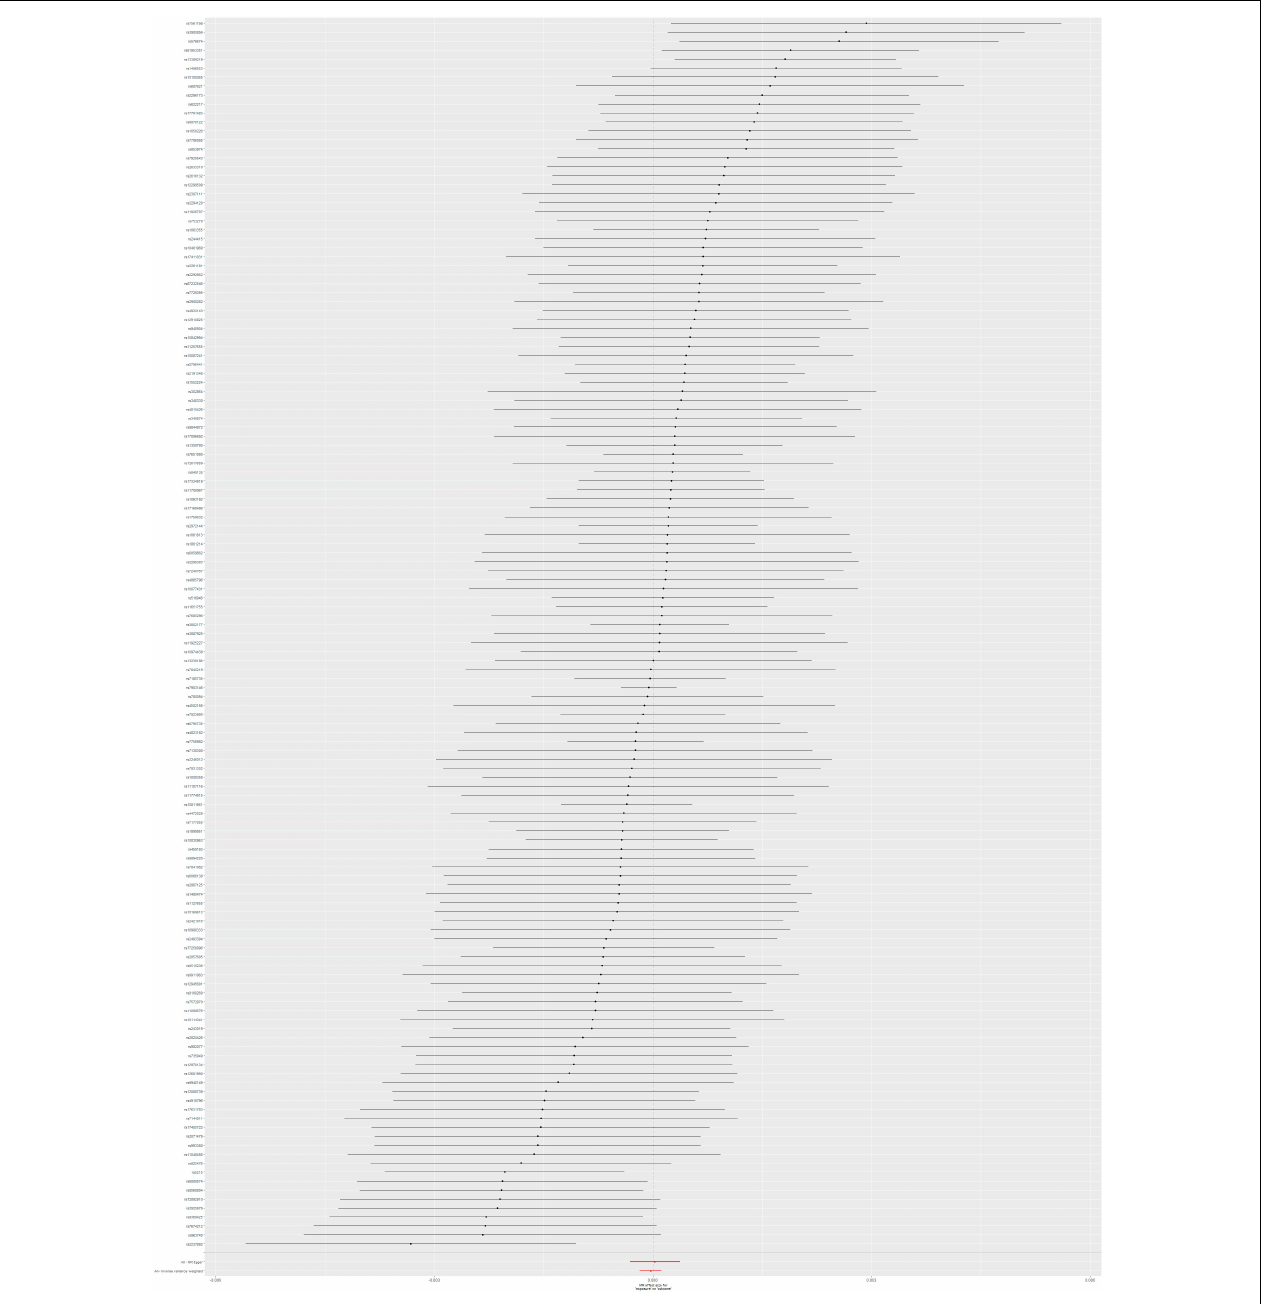
FIGURE 5 | Forest plot: the associations between T2DM-related SNPs and pneumonia risk. T2DM, type 2 diabetes mellitus; SNPs, single-nucleotide polymorphisms; OR, odds ratio; CIs, confidence intervals.